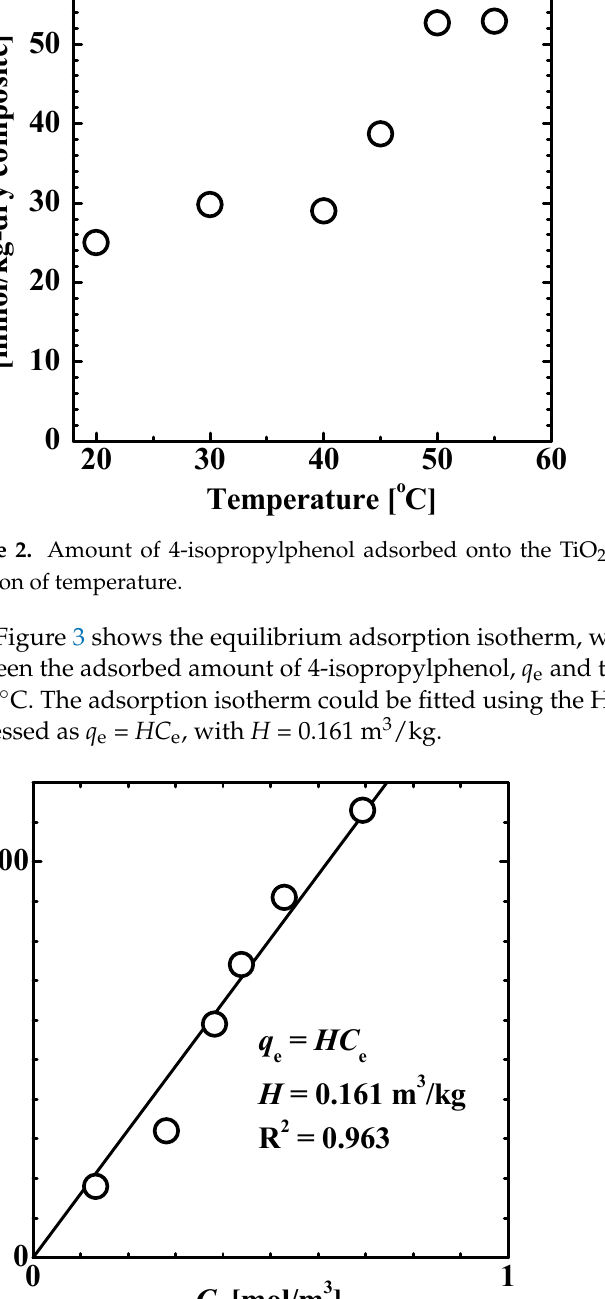
Figure 3. Equilibrium adsorption isotherm showing the relationship between the amount of 4-iso- propylphenol adsorbed, q e onto the TiO 2 nanoparticle-loaded fiber and the equilibrium concentra- tion of 4-isopropylphenol, C e in the solution at 50 °C. The solid line represents the fit of the data using the Henry-type isotherm function.